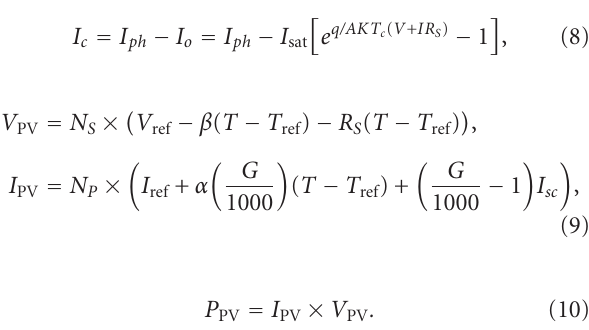
VrefDiscrete. Figure 4: Inverter system simulation model using dSPACE